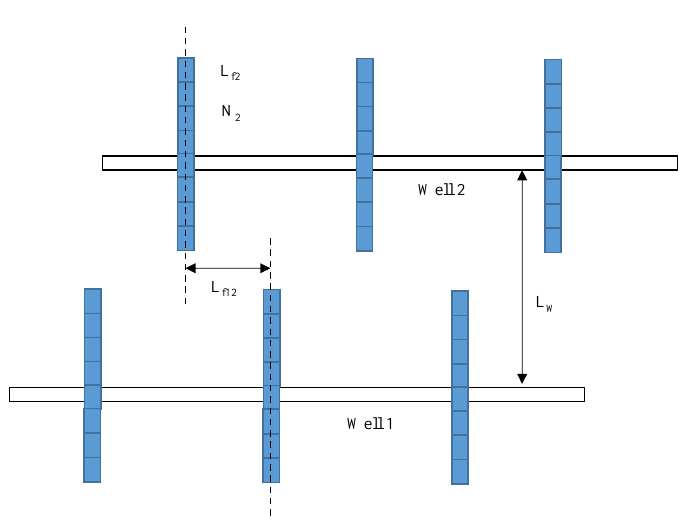
Figure 2. Subdivision of hydraulic fractures in WIPS scheme.